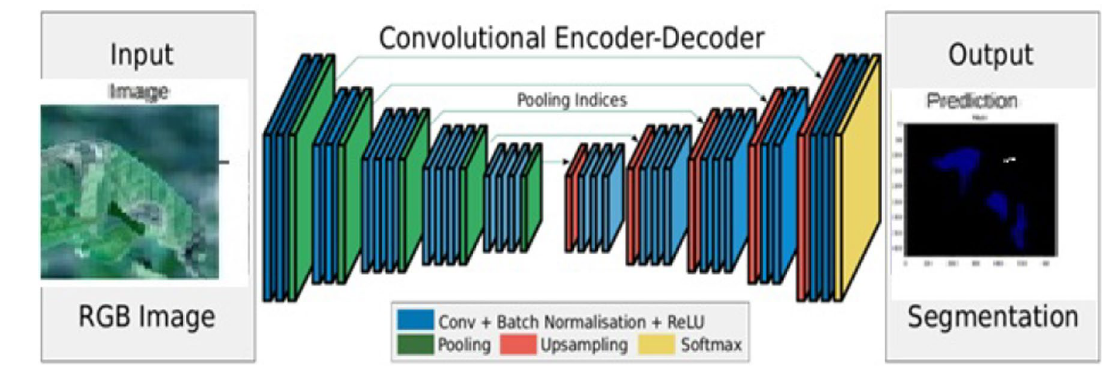
Fig. 3 The architecture of the SegNet